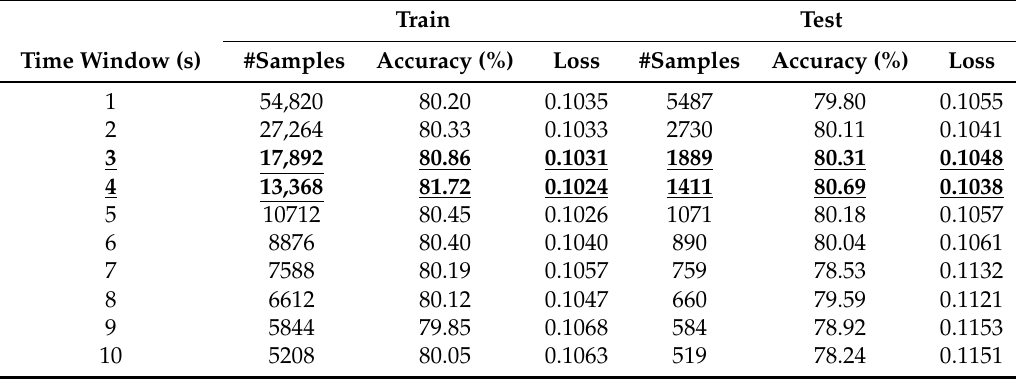
Table 4. Results obtained with ECG network classifying Arousal (best time windows are marked). Train Test Time Window